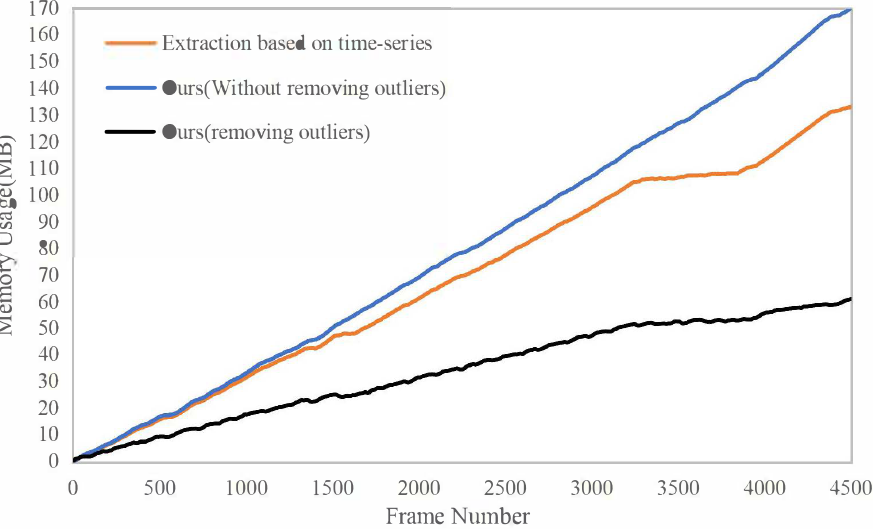
in an incomplete reconstruction scene.